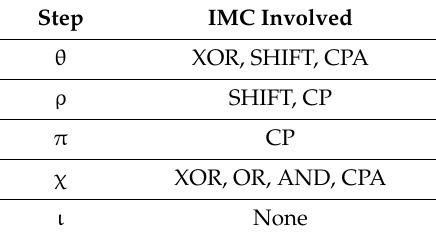
Table 2. In-memory computing (IMC) applications in Keccak- f permutation. XOR—exclusive